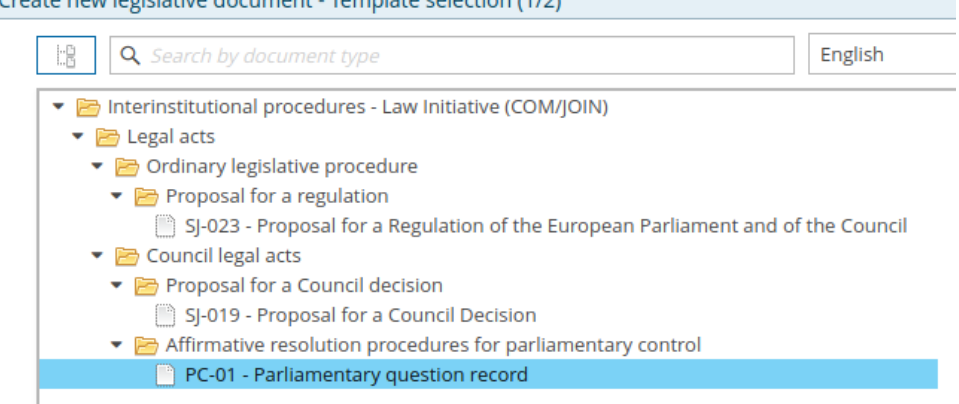
Figure 3. Web UI rendition based on the uploaded document.